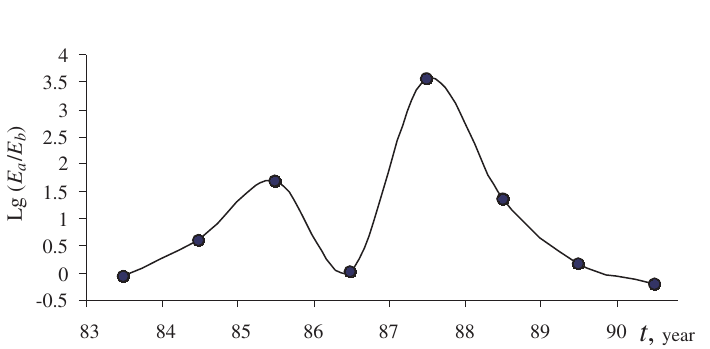
Fig. 8. Average annual values of E a / E b being the ratio of total seismic energy of earthquakes of the North Tien Shan occurring 5 days after and 5 days before MHD-generator start-ups in the upper 5 km layer as a function of time. The values E a / E b are plotted on a logarithmic scale.